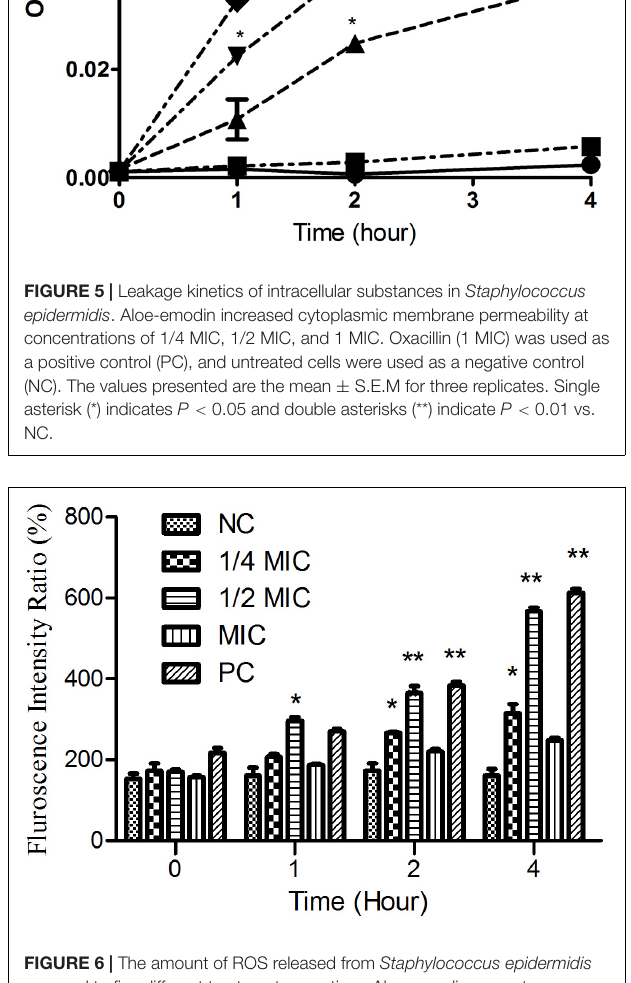
FIGURE 6 | The amount of ROS released from Staphylococcus epidermidis exposed to five different treatments over time. Aloe-emodin promotes endogenous ROS production at concentrations of 1/4 MIC, 1/2 MIC, and 1 MIC. Oxacillin (1 MIC) was used as a positive control (PC) and untreated cells were used as a negative control (NC). The statistical analysis of ROS production was compared with the NC. Single asterisk (*) indicates P < 0.05 and double asterisks (**) indicate P < 0.01 vs.